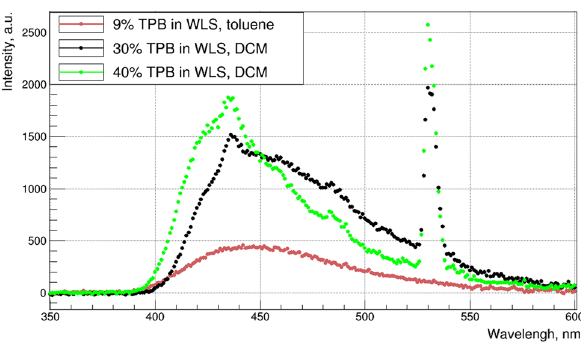
Fig. 2 Fluorescence spectra of the coated nylon samples with different composition of WLS measured with a Cary Eclipse UV spectropho- tometer. The peak at 530 nm is a light contamination presumably from the excitation beam